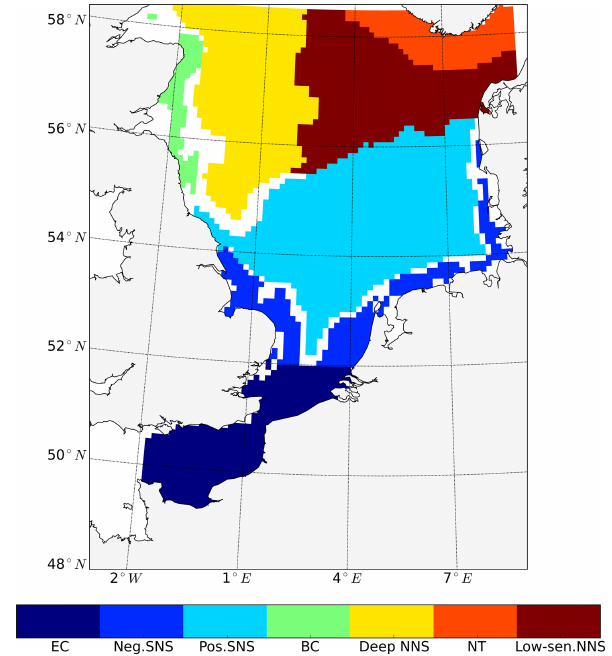
Figure 4. Process-oriented subdomain division of the North Sea based on tidally induced changes in net primary production and bathymetric characteristics (EC: English Channel; neg. SNS: neg- atively responding southern North Sea; pos. SNS: positively re- sponding southern North Sea; BC: eastern British coast; deep NNS: deeper northern North Sea; NT: Norwegian Trench; low-sen. NNS: low-sensitivity northern North Sea). Areas with an absolute varia- tion in NPP less than 5gCm − 2 year − 1 are excluded, except for the low-sen. NNS